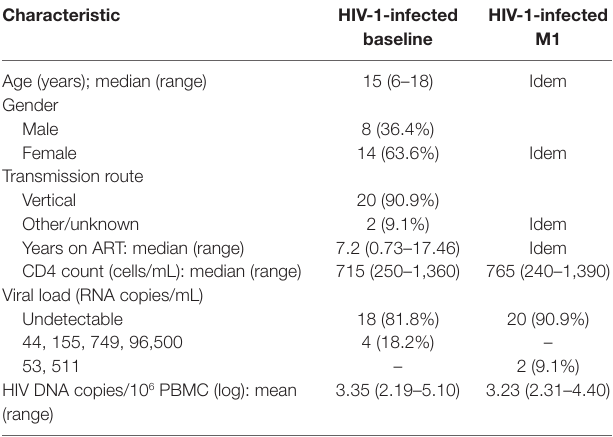
TaBle 1 | Clinical characteristics of HIV-1-infected children included in the study. characteristic